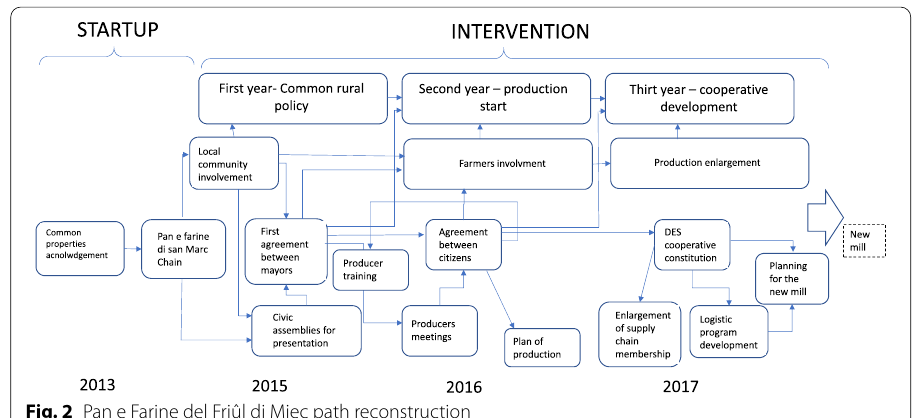
Fig. 2 Pan e Farine del Friûl di Mieç path